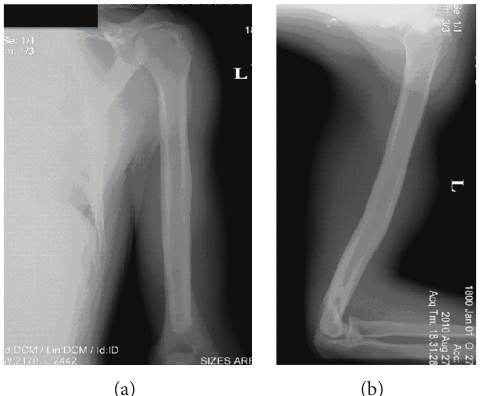
Figure 4: Anterior-posterior and lateral radiographs of the left humeral shaft at 10-year followup. The patient has near anatomic alignment in the coronal plane and a 10-degree anterior bow in the sagittal